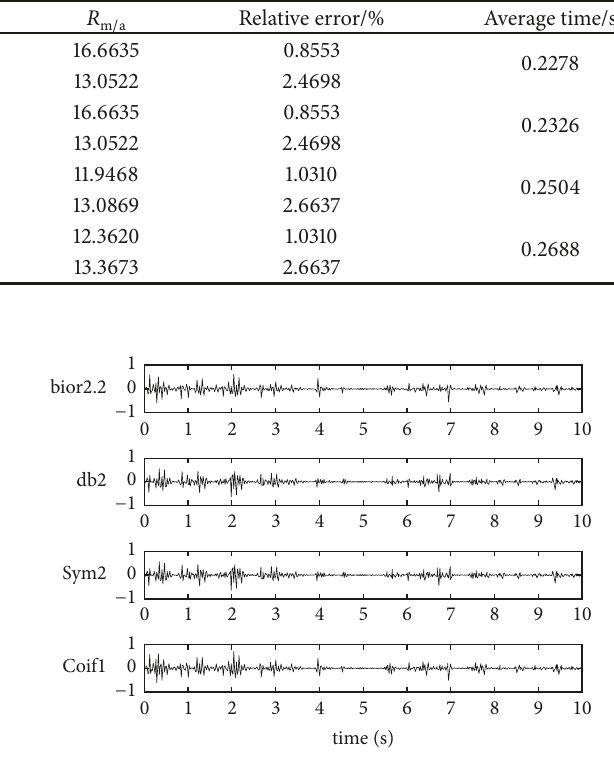
Figure 11: Detail coefficients of the envelope method with different wavelets.